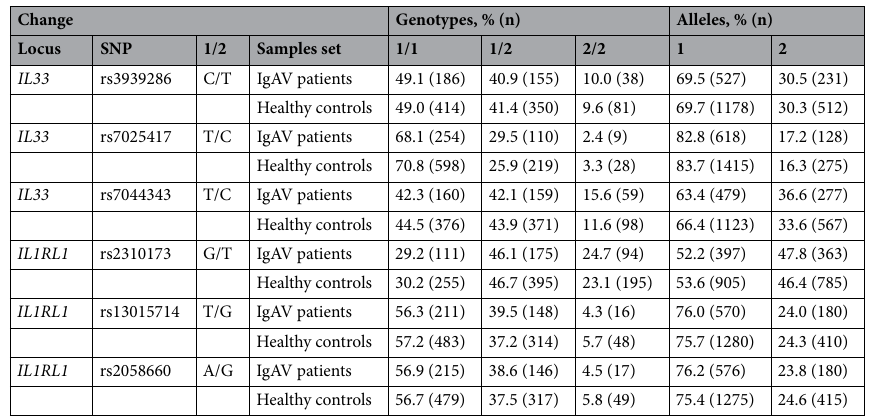
Table 2. Genotype and allele frequencies of IL33 and IL1RL1 genes in patients with IgAV and healthy controls. IgAV: IgA vasculitis; SNP: single nucleotide polymorphism. No statistically significant differences in the IL33 and IL1RL1 genotype and allele frequencies were disclosed when patients with IgAV were compared to healthy controls ( p ≥ 0.05 in all the